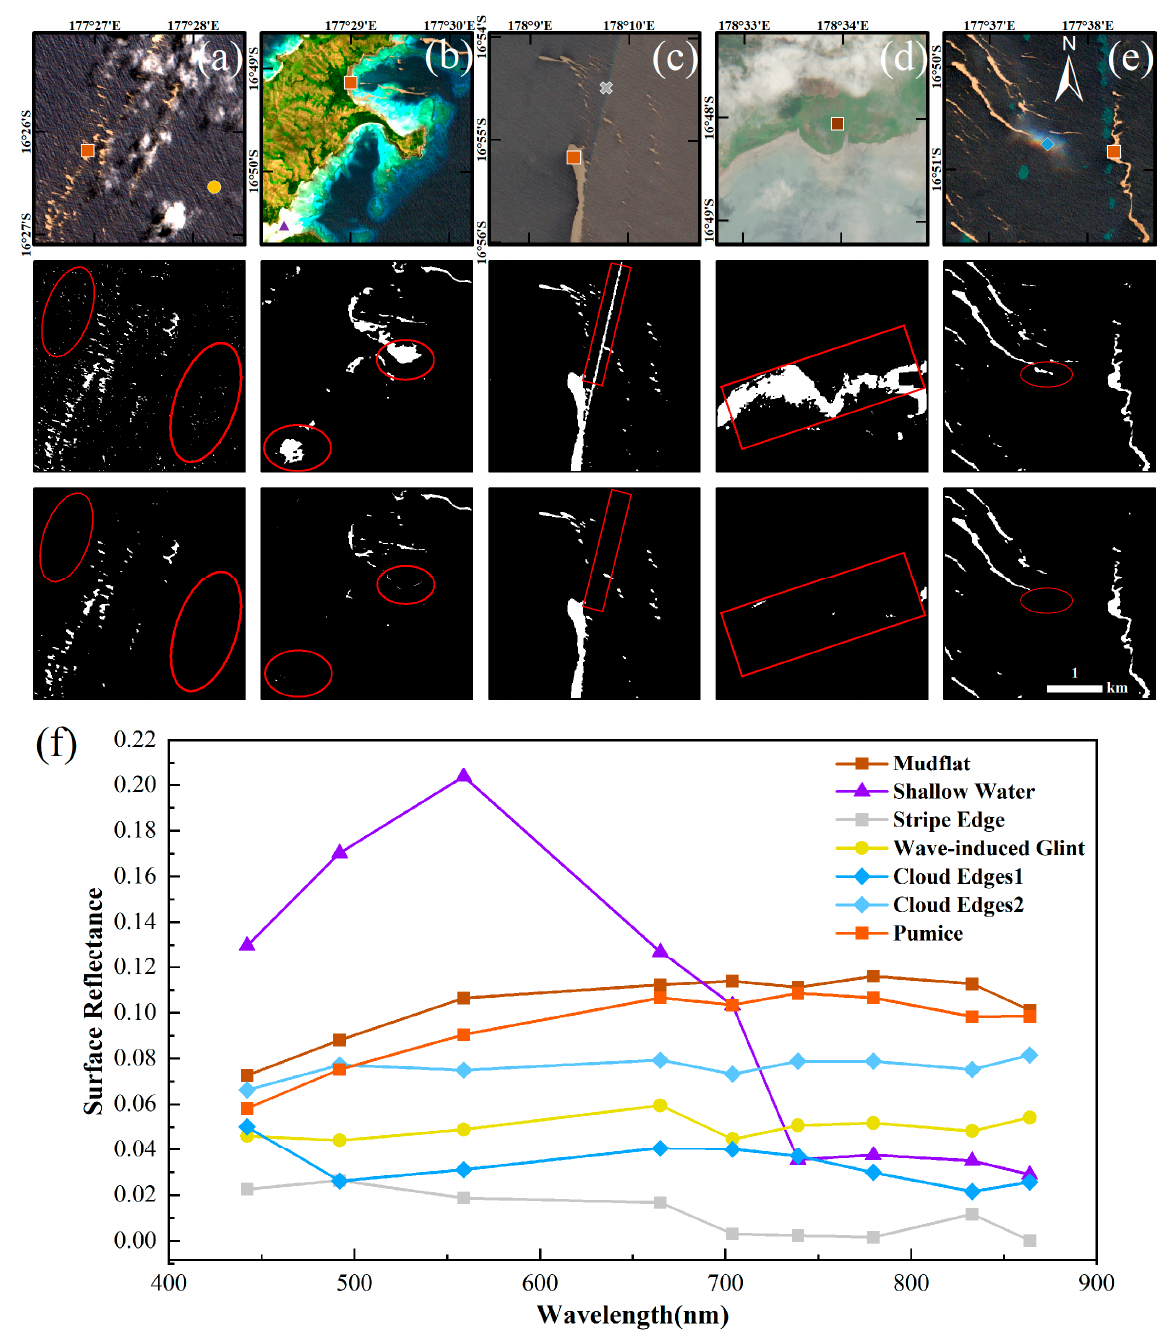
Figure 5. Examples of RGB image, the initially extracted PRI, and PRI image after ( a ) TV screen, and after the removal of false-positive detections from ( b ) shallow water, ( c ) stripe edge, ( d ) mudflat, and ( e ) cloud edge, respectively. Scattered noise and false-positive detections from the various targets marked in red eclipses and rectangles have been successfully removed after the procedures described in Section 3.3. ( f ) Average reflectance spectra of mudflat, shallow water, stripe edge, wave-induced glint, cloud edges and pumice in selected locations, partly marked in panels ( a – e ).